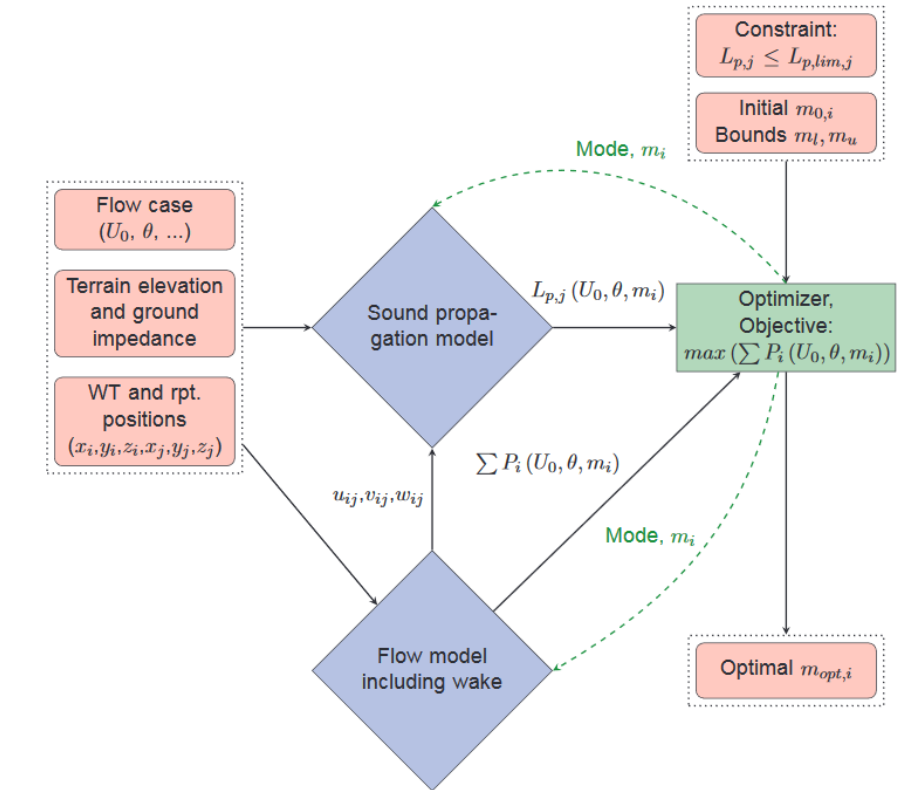
Figure 1. Flow chart of the optimization framework structure. The flow chart can both be used for the ISO 9613-2 model and the WindSTAR model.